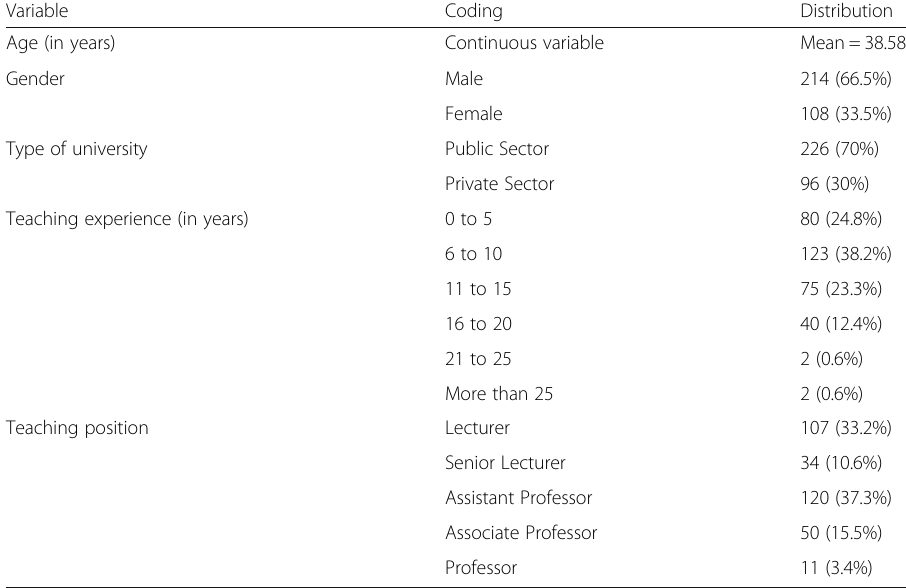
Table 1 Descriptive statistics for demographic